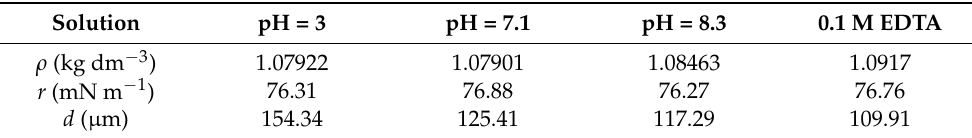
Table 2. The density ( ρ ), surface tension ( γ ), and break-off diameter ( d ) of Ni electrodeposition solutions with different pH values and